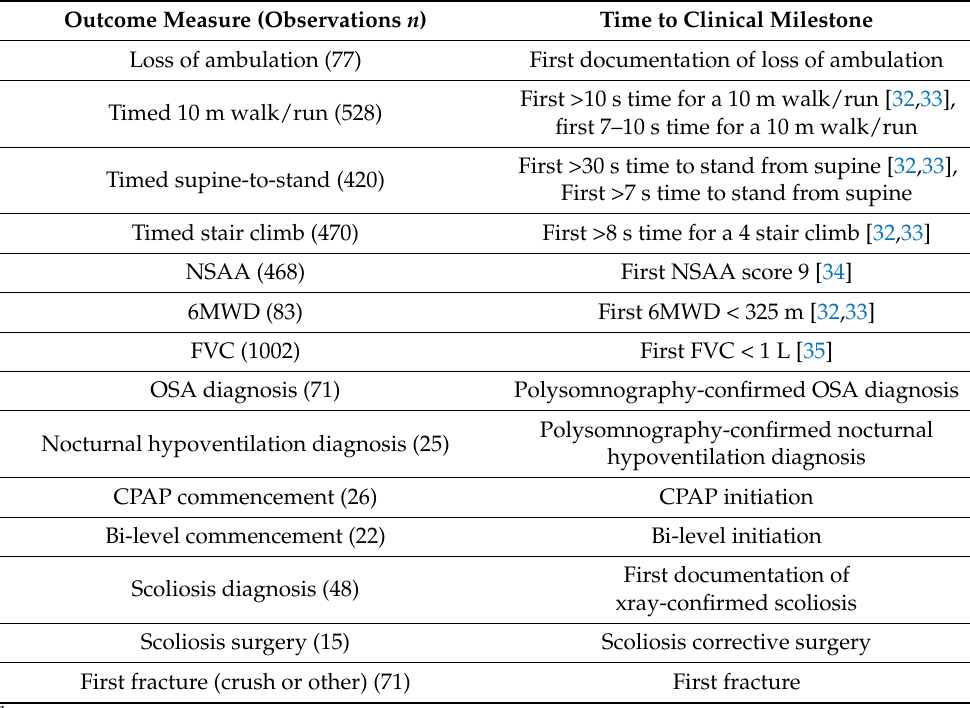
Table 1. Clinical Milestones Used in Time-to-Event Analyses 1